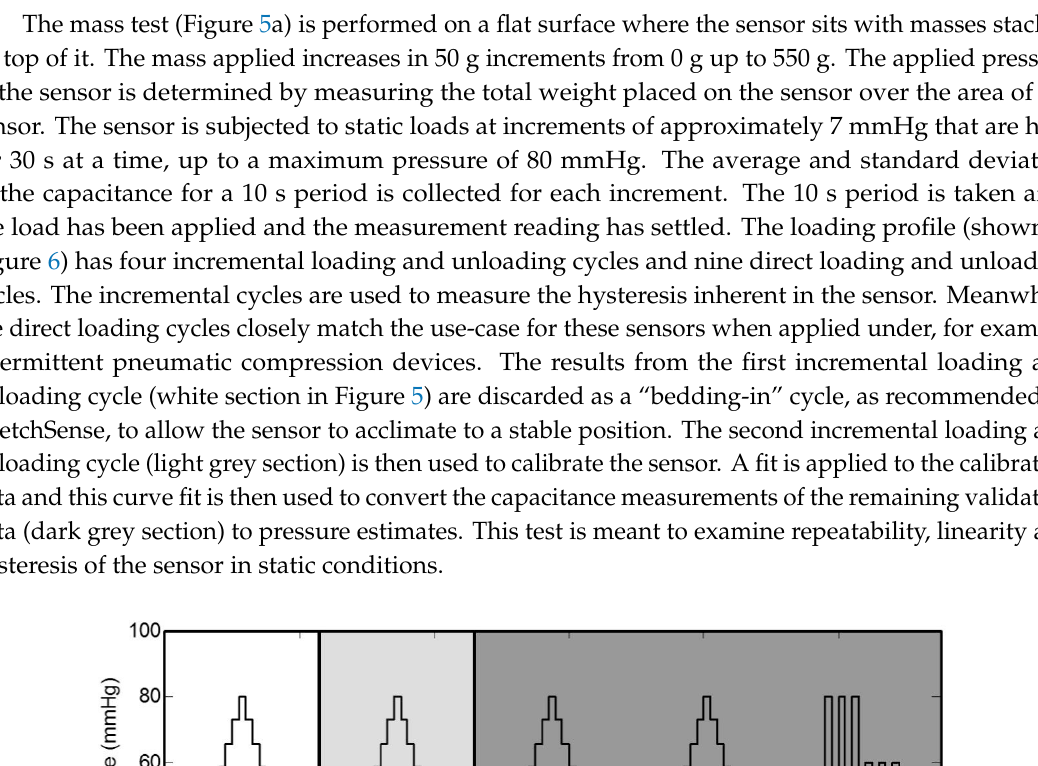
Figure 6. Testing protocol for applied load on sensor in the static tests.